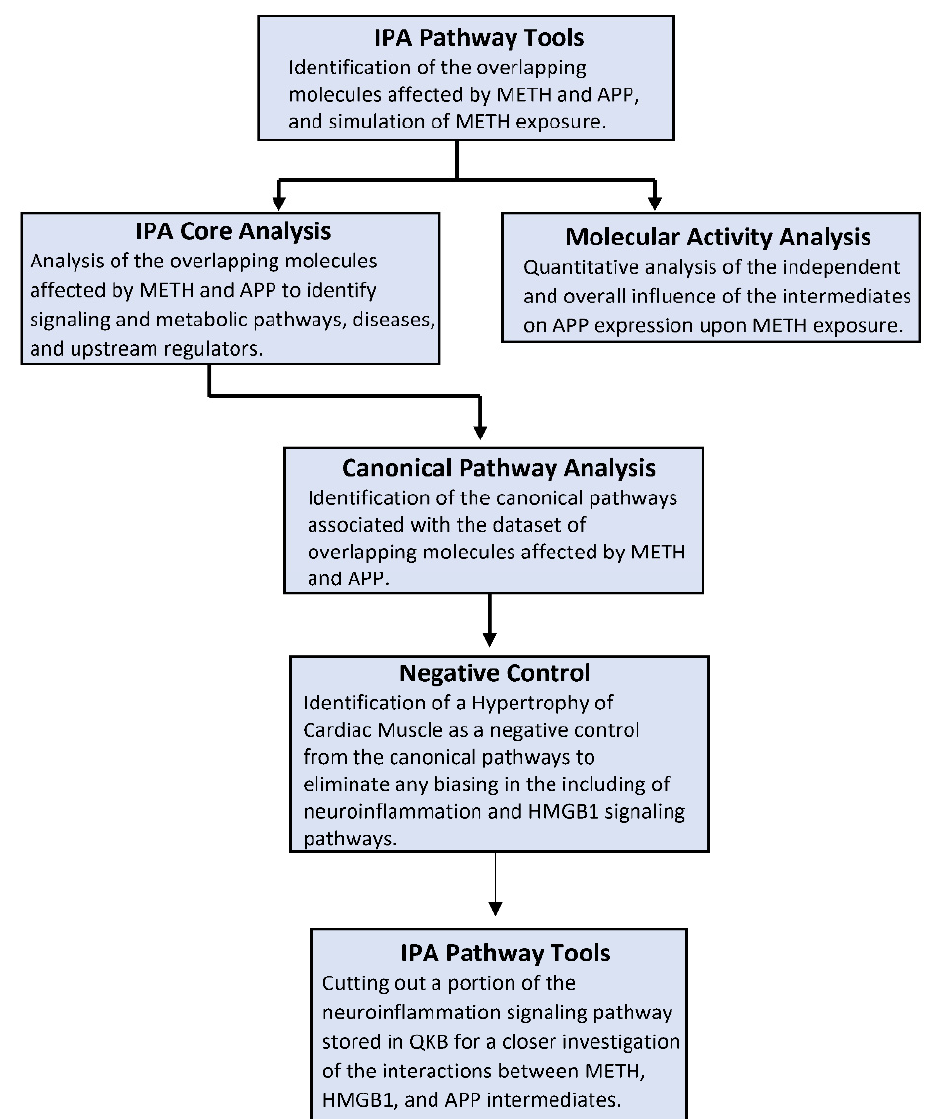
Figure 1. Methods Flowchart. The steps involved in utilizing the resources offered by IPA are outlined in the flowchart. The first step was to use the basic IPA pathway tools, including but not limited to “Grow”, “Trim”, “Connect”, “Pathway Finder”, and “MAP”. The molecular activity analysis was conducted after the generation of every pathway using mathematical algorithms and data stored in QKB. A core analysis was run on the dataset of molecules from every generated pathway; the resulting canonical pathways were analyzed to identify the role of the molecules within the canonical pathways. IPA tools were again used to excise a portion of the neuroinflammation signaling pathway stored in QKB for a closer and more detailed look of the implicated molecules. The cumulative z-score of METH impact on APP expression in the network was 3.5 [29,30], corresponding to a p -value of 0.000453 of a two tailed distribution; this indicates that the likelihood of finding the same results by chance occurs less than 1% of the time. The weights computed for the 8 molecules compiled in Figure 3 indicate the directionality of the change in APP expression, ranging from − 2 (decrease) to +2 (increase), and the confidence of each expression change [29]. Out of the 8 molecules predicted to undergo activity changes upon METH exposure, JUN, MAPK3, MMP9, IL6, IL1B, TNF, and IL1 were predicted to upregulate APP expression with a Z-score of more than 1.5, while IGF1R was predicted to affect APP expression with a Z-score of less than 0.5. The overall impact